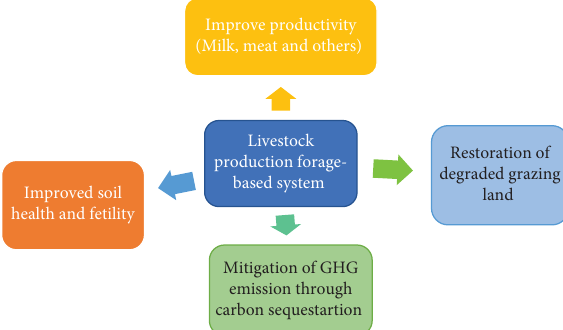
Figure 2: Role of forage-based livestock production in smart ways [66].